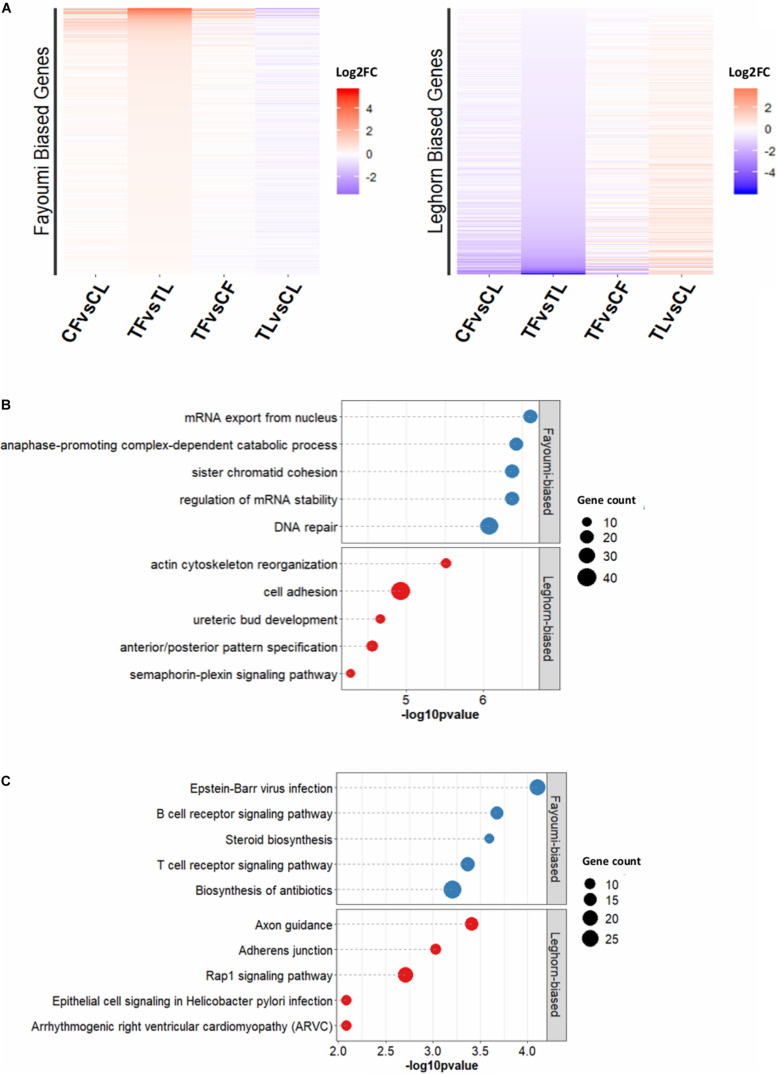
Functional analysis of DEGs specific for treated-line comparison. (A) Log2FC for Fayoumi-biased and Leghorn-biased DEGs specifically within treated-line comparison compared to control-line comparison. (B) The top 5 GO terms for Fayoumi-biased and Leghorn-biased DEGs specific to the treated-line comparison. (C) The top 5 KEGG pathways for Fayoumi-biased and Leghorn-biased DEGs specific to treated-line comparison.